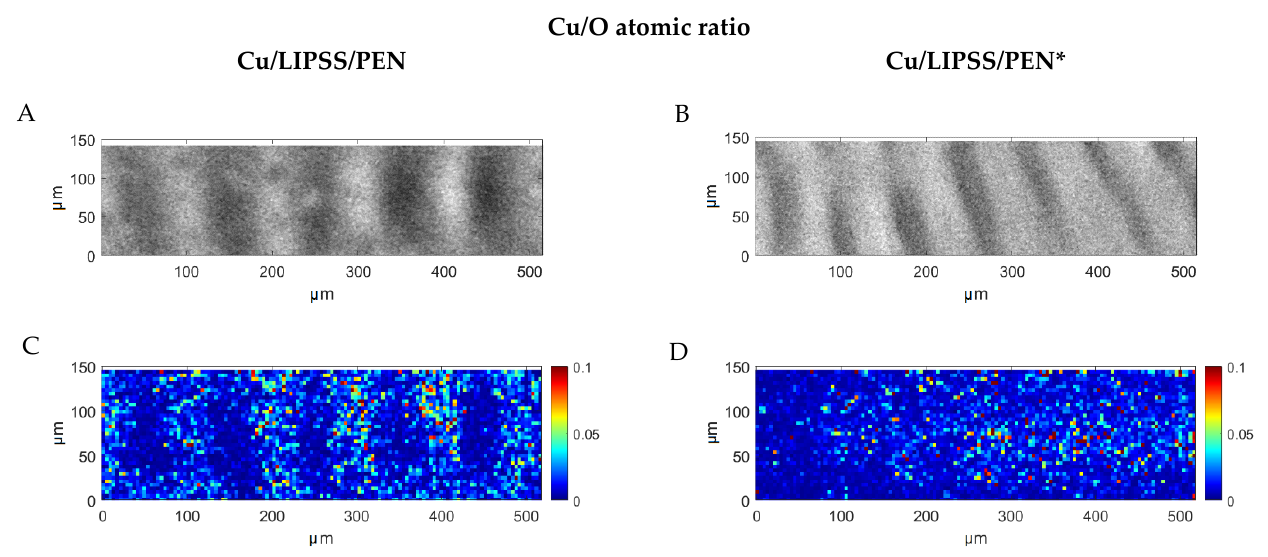
Figure 3. SEM images ( A , B ) and the corresponding EDS maps ( C , D ) showing the Cu/O ratio at. %. The mean values were calculated for each map.